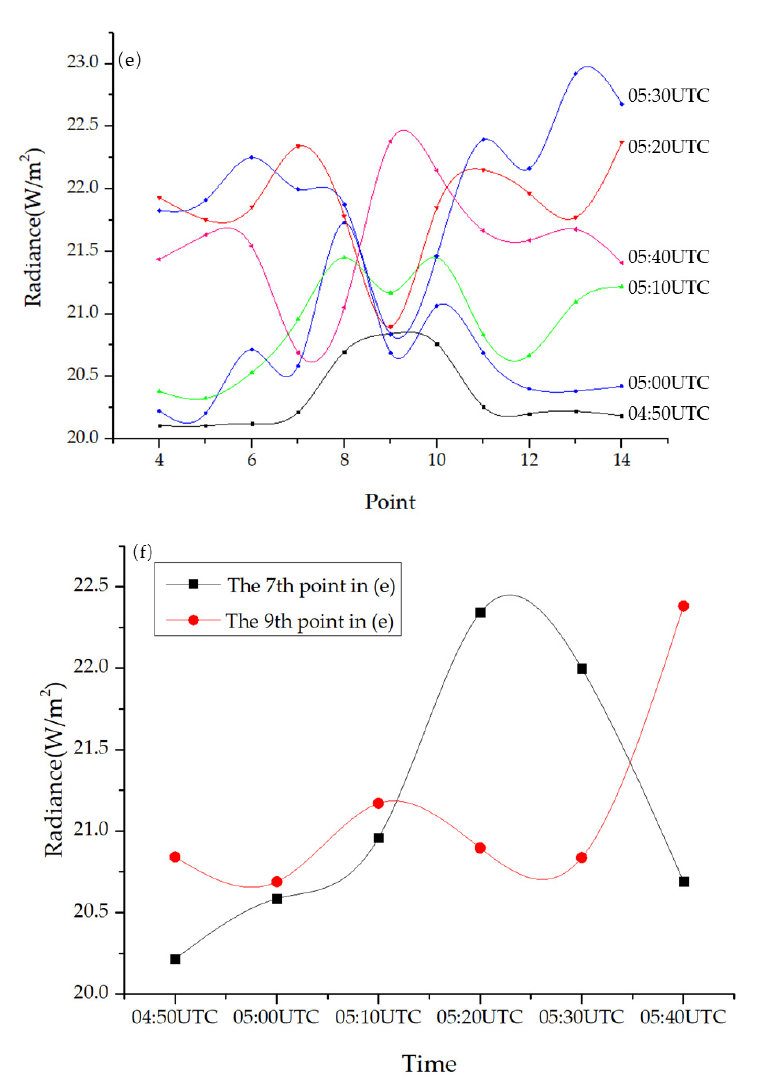
Figure 6. The time sequence change of the radiance of 5 certain points on the same leading wave with time and space. ( a ) shows the spatial changes of 5 points on the same leading wave at 04:50–05:40 UTC, and the types of the same leading wave at different moments are different, and the 5 points are represented by different colors, which the arrows show the propagation direction; ( b ) shows the time changes of the radiances of 5 certain points on the leading wave. The colors of 5 points in ( a ) correspond to the colors of 5 curves in ( b ) and the average of 5 curves is also shown. ( c ) shows the radiance curves of the dark band at 04:50-05:40 UTC. The radiances at 04:50 UTC are lower than 05:00 UTC as a whole. Additionally, the radiances at 05:00 UTC are lower than 05:10 UTC as a whole. The radiances at 05:10 UTC are lower than 05:20 UTC as a whole. Therefore, the radiance of dark band is increasing. The radiances at 05:40 UTC are lower than 05:30 UTC, so the radiance of the dark band is decreasing. ( d ) shows the radiances of the bright band at 04:50–05:40 UTC. The radiances at 04:50 UTC are lower than 05:00 UTC as a whole. Additionally, the radiances at 05:00 UTC are lower than 05:10 UTC as a whole. The radiances at 05:10 UTC are lower than 05:20 UTC as a whole. The radiances at 05:20 UTC are lower than 05:30 UTC as a whole. The radiances at 05:30 UTC are lower than 05:40 UTC as a whole. Therefore, the radiance of the bright band is increasing. ( e ) superimposes the profiles of internal waves in Figure 5 at 04:50–05:40 UTC. The bright and dark band in images at 04:50–05:40 UTC are corresponding. The X-axis number is corresponding to the X-axis number of profiles in Figure 5. ( f ) shows the radiance curves of the 7th point and the 9th point in Figure 6e at different moments. In Figure 6a, the spatial changes of five points on the same leading wave at 04:50–05:40 UTC are shown. Due to the low spatial resolution of Himawari-8 images, the leading wave does not seem to be very smooth and the distances of internal wave at different moments are